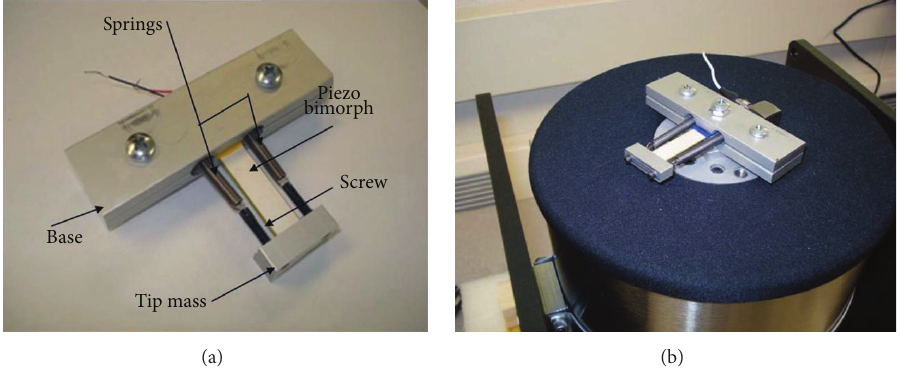
Figure 15: PE-VEH produced for vibration in civil structures